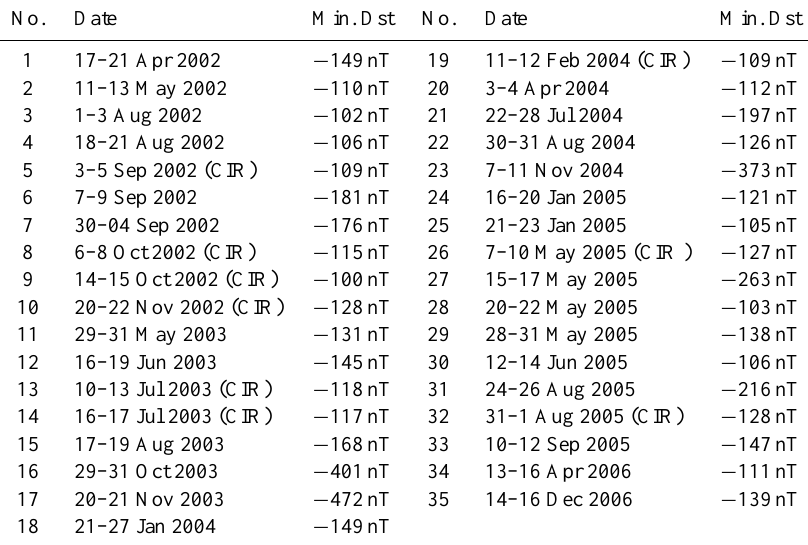
Table 1. A list of storm